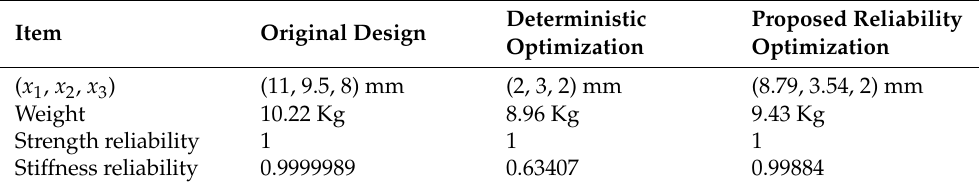
Table 4. Reliability design optimization results for the big arm.